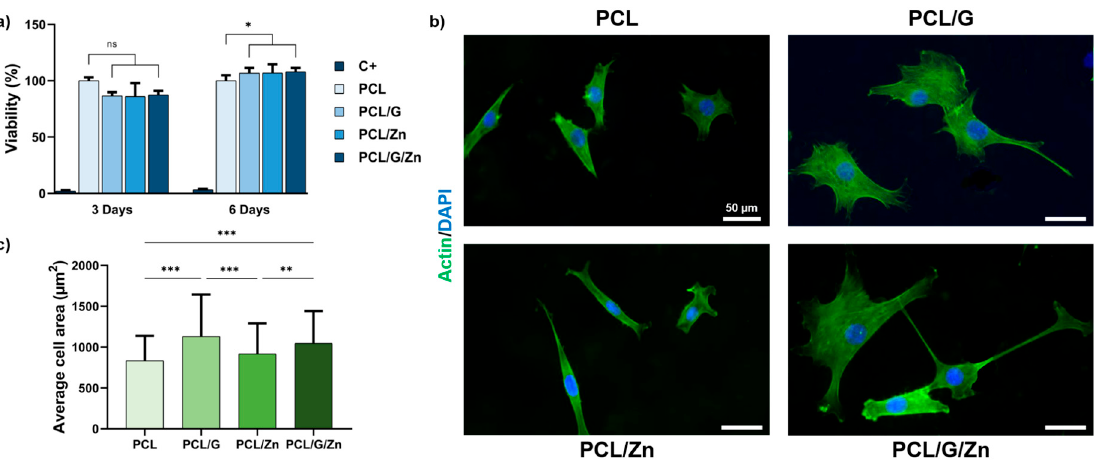
Figure 3. ( a ) MTS cytotoxicity. Cell viability after 3 and 6 days. Positive control: latex extract, negative control: neat PCL surface; ( b ) Immunofluorescence images of cell adhesion (actin staining); ( c ) Average cell adhesion area for the different conditions. (*) p < 0.05, (**) p < 0.01 and (***) p < 0.001.